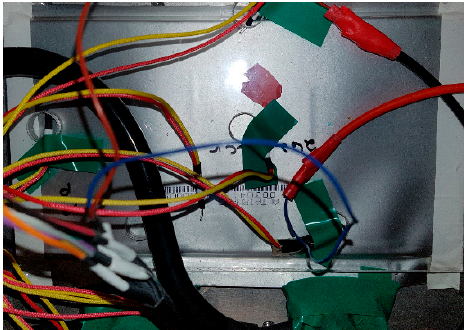
Figure 1. The lithium-ion battery cell.